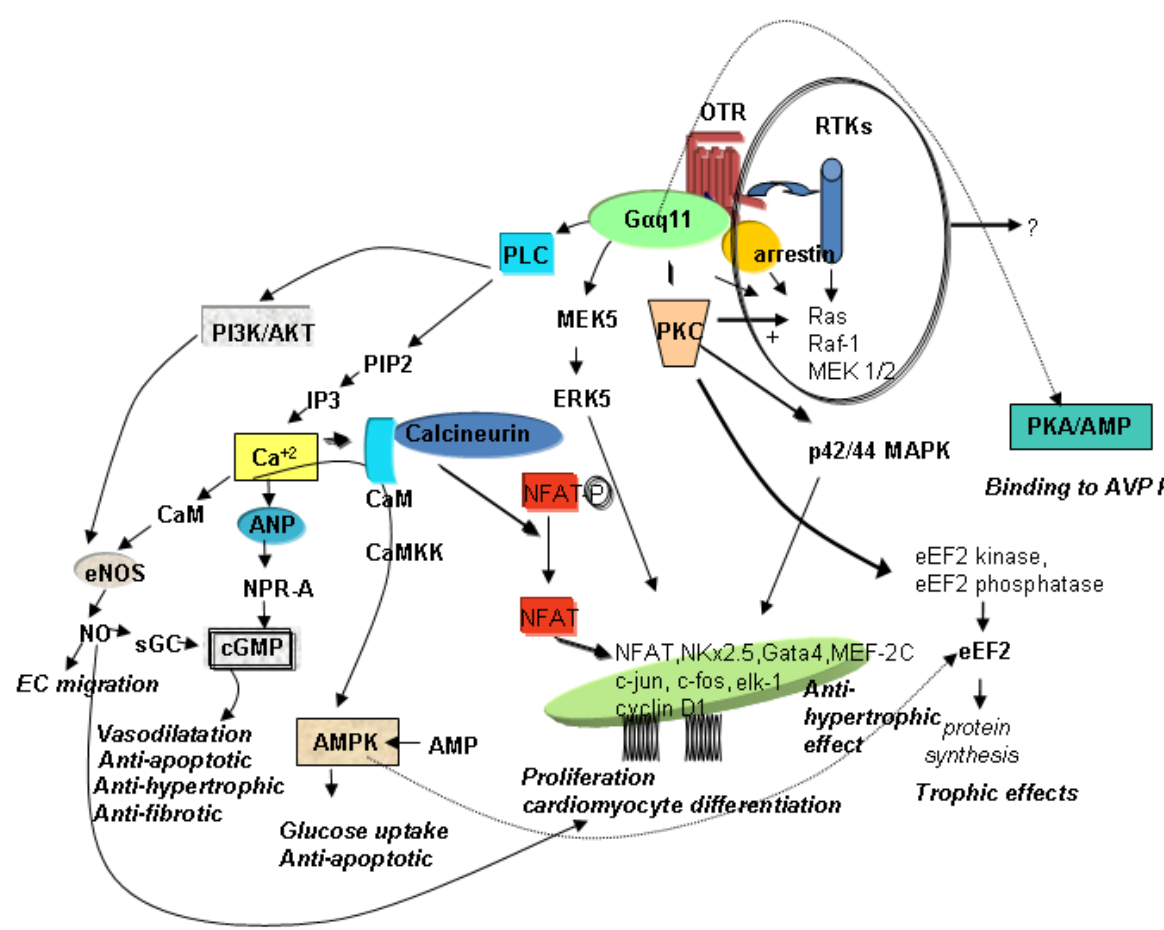
Figure 1. Schematic diagram of potential signalling pathways of OTR in